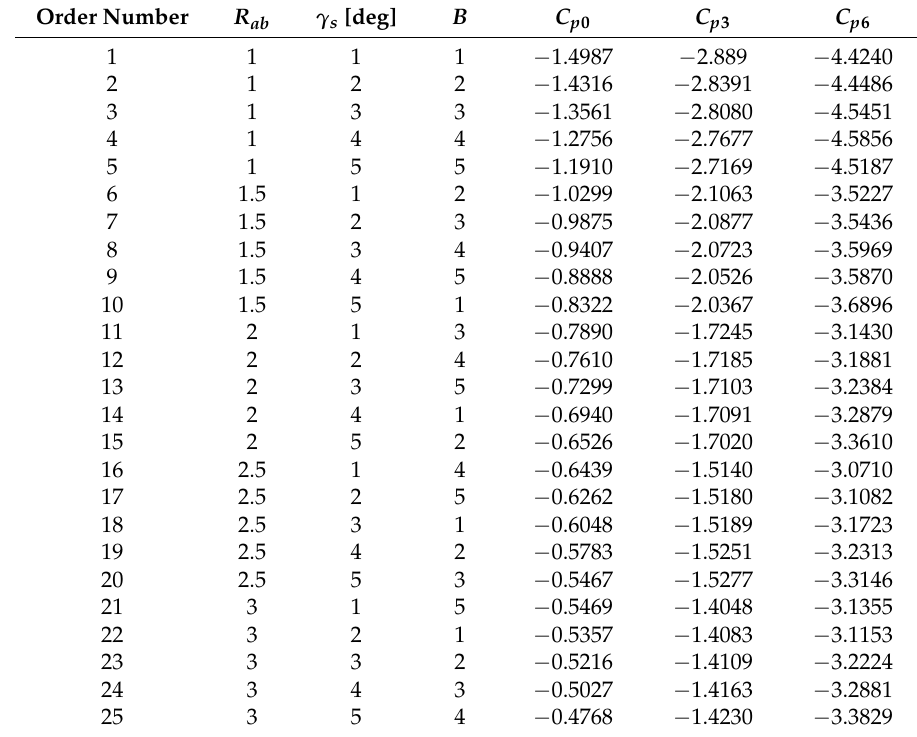
Table 3. Orthogonal test table with factors, levels and test values.